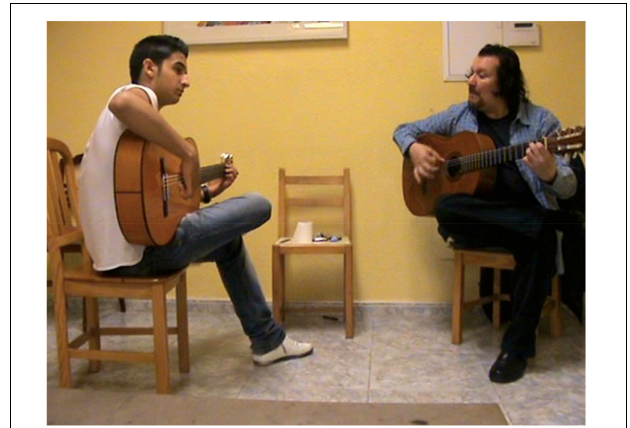
FIGURE 2 | One-to–one class between the flamenco teacher Entri with student R, sitting opposite, with the teacher looking at the apprentice’s fretboard and the apprentice looking at the teacher’s